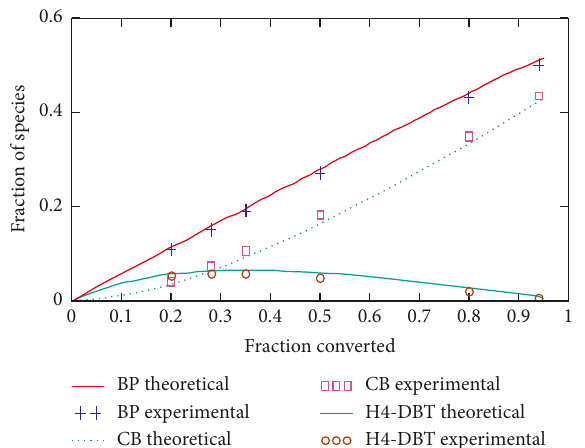
Figure 5: Transformation of dibenzothiophene over the C-ATS-I catalyst in the absence of H 2